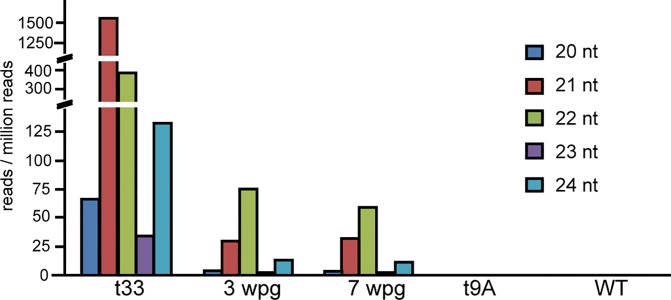
Fractions of 20–24 nt siRNA mapped to GBSSI target region in different materials.3 wag and 7 wag are adventitious shoots (Fig 1B4) in rootstock of trans-grafted plants at 3 weeks and 7 weeks after grafting, respectively. Epi-A is t9A in Fig 3.